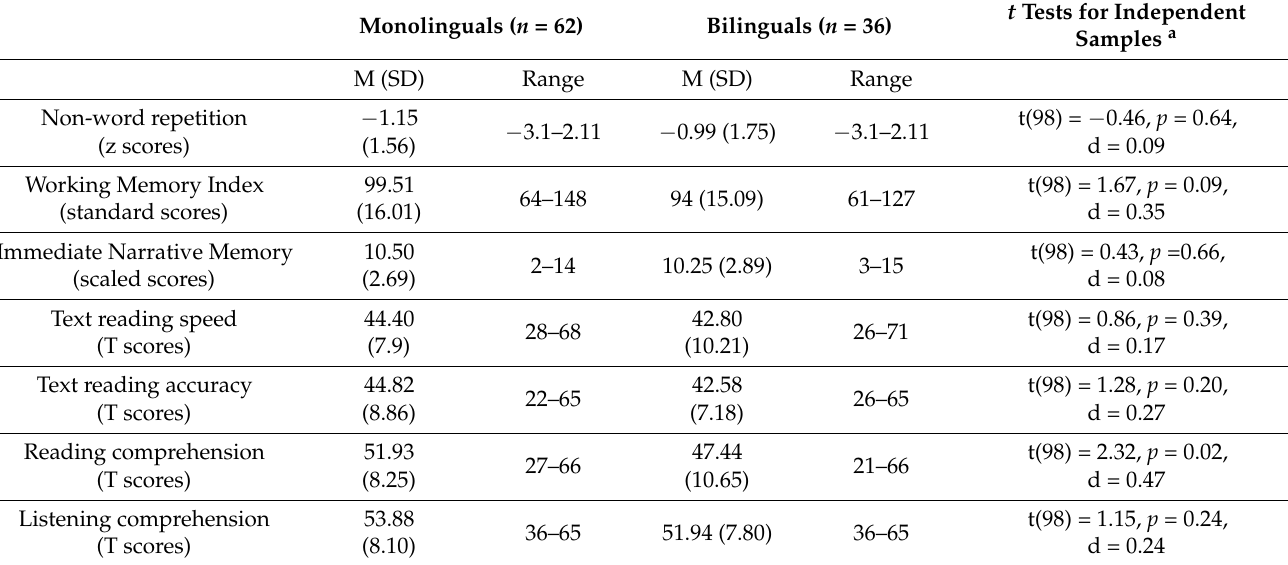
Table 1. Mean standard scores on working memory and reading measures for monolingual and bilingual children. Monolinguals ( n = 62) Bilinguals ( n = 36)